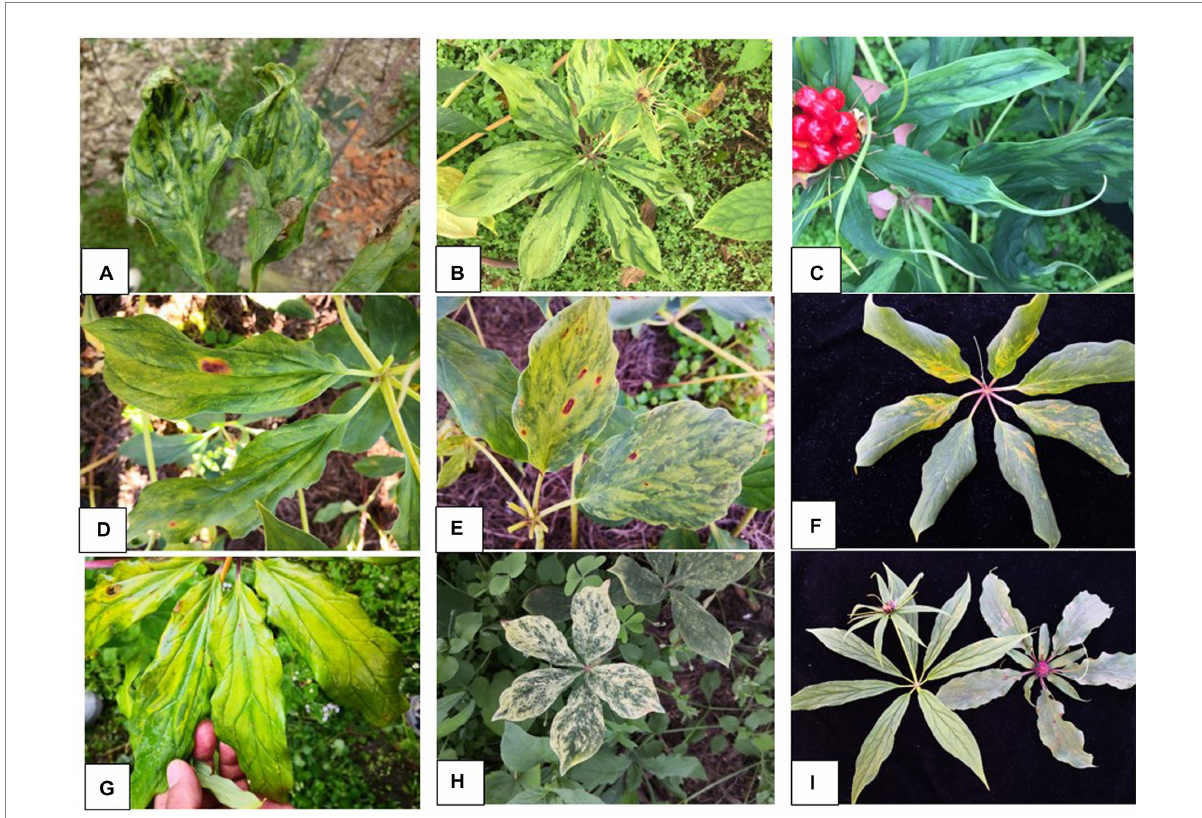
FIGURE. 1 Symptoms of virus diseases on leaves of Paris yunnanensis plants: (A) mosaic and deformation, (B) mosaic and green banding, (C) mottle and linear leaf, (D) chlorosis and necrosis, (E) mosaic and necrosis, (F) macula and chlorosis, (G) mosaic and chlorosis, (H) whiting, and (I) pedicel